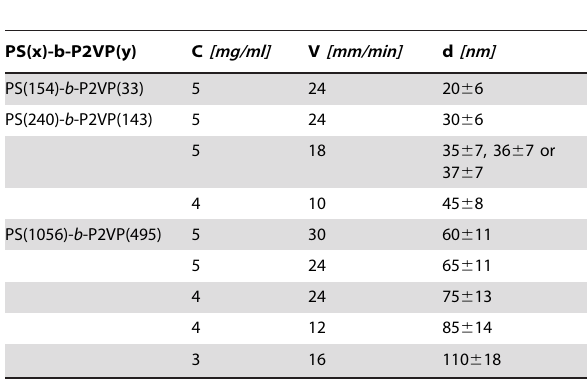
Table 1. Parameters for producing nanostructured surfaces by